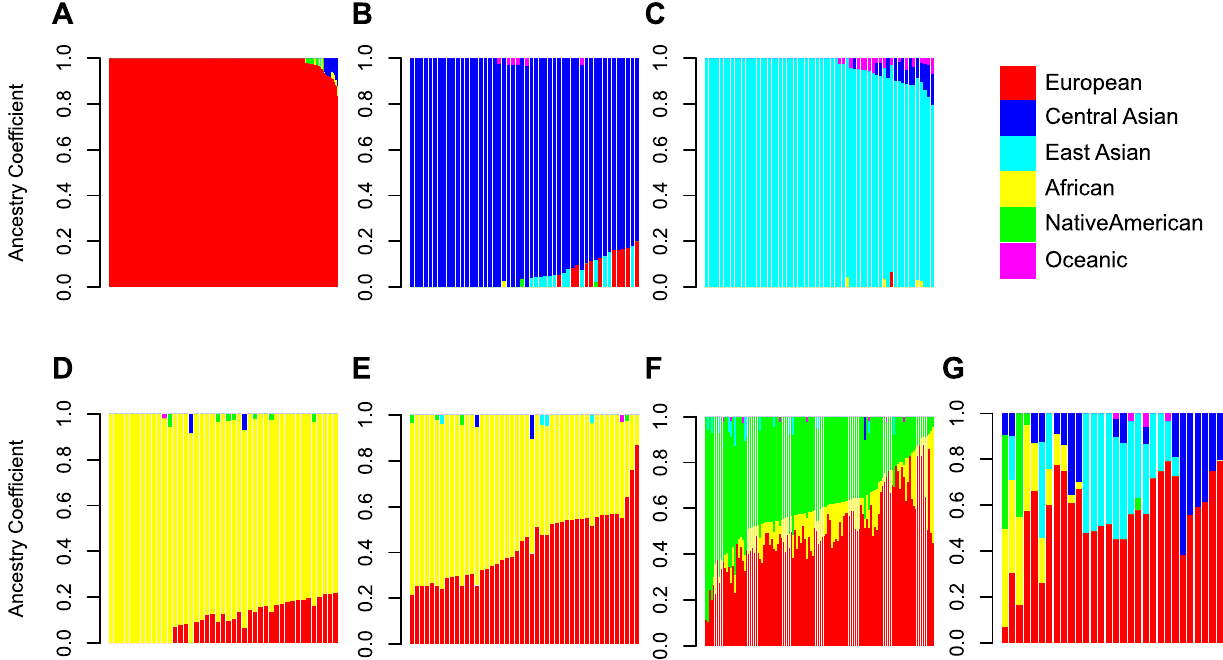
Figure 2. Admixture coefficients for the subpopulations. The admixture proportions of the 6 ancestral populations (colors) are displayed for all individuals in each of the 7 groups defined in the cohort (panels). (A) European (B) Central Asian (C) East Asian (D) African (E) African-European (F) Hispanic (G) Other. Red: European, Blue: Central Asian, Cyan: East Asian, Yellow: African, Green: Native American, Magenta: Oceania.